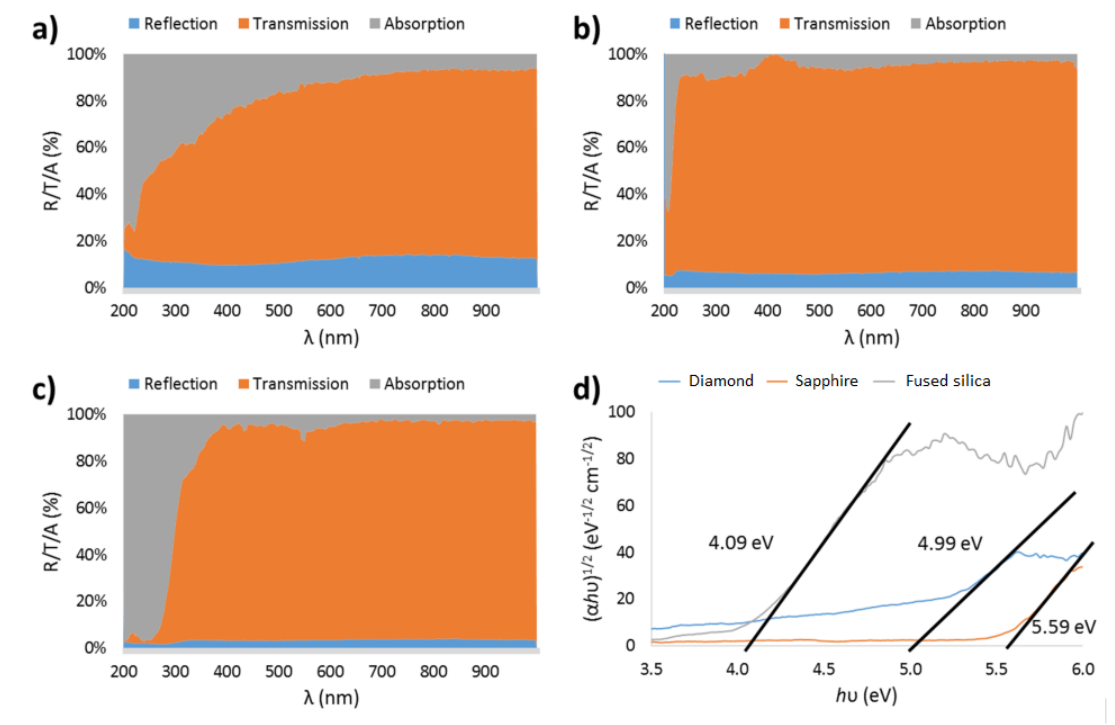
Figure 2. The proportion of light absorbed (A), reflected (R), and transmitted (T) by ( a ) diamond, ( b ) sapphire, and ( c ) fused silica. ( d ) Tauc plot calculating the optical band-gap for each material (diamond, sapphire, and fused silica).